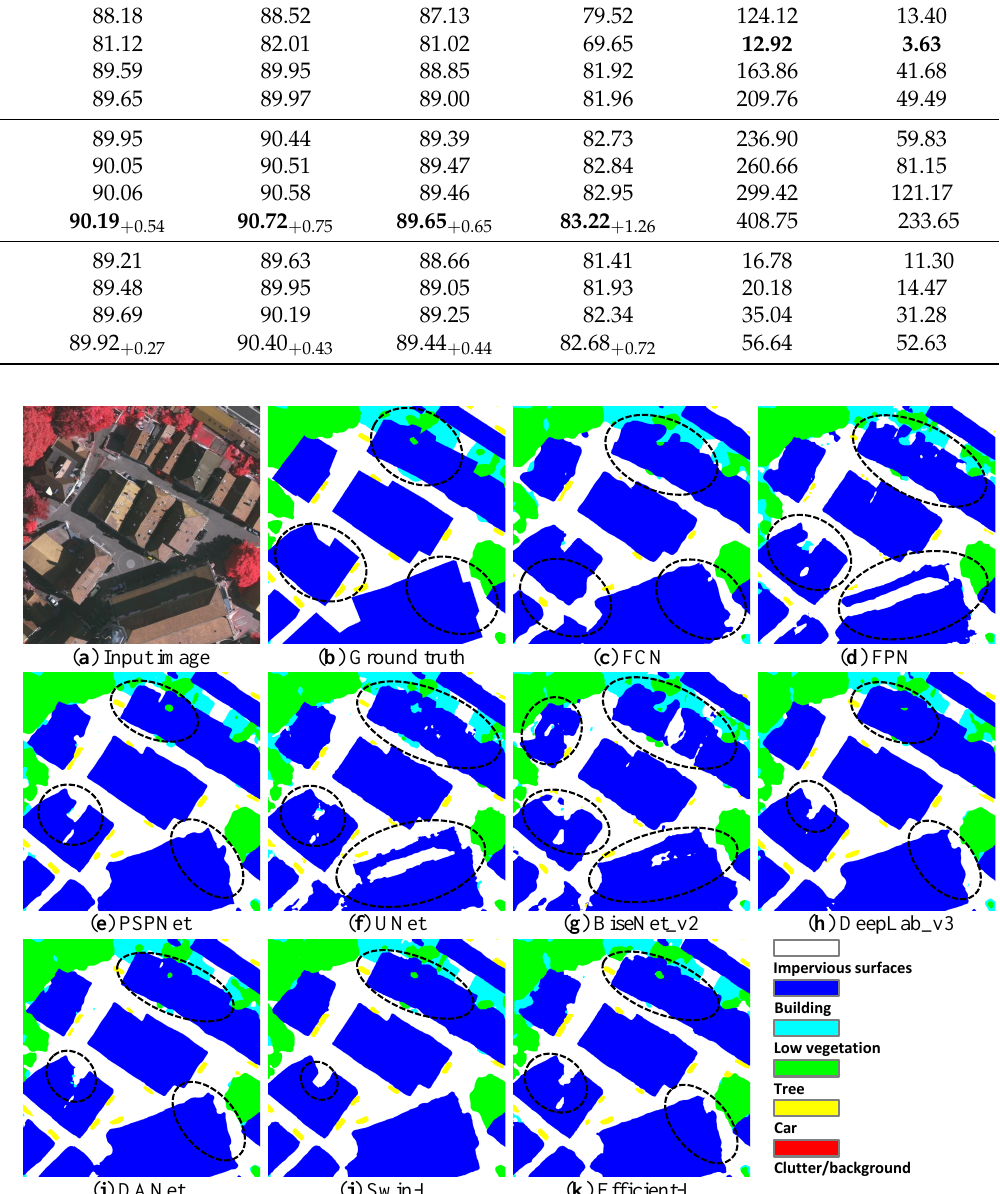
Figure 14. Prediction maps of the compared methods on the Vaihingen